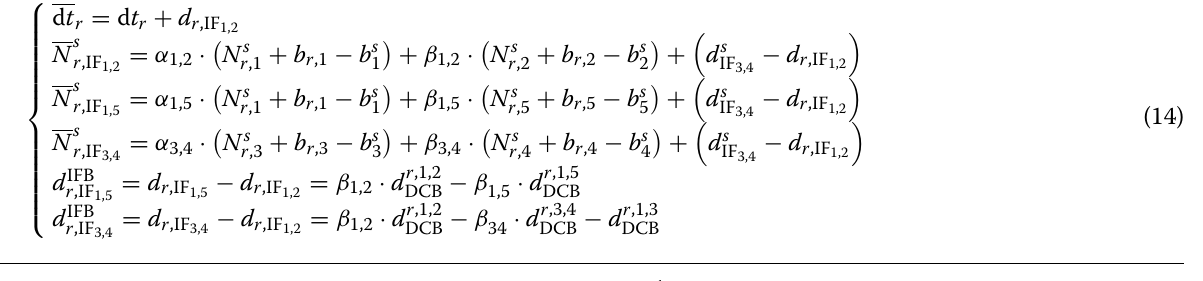
FF4: model with one single triple‑frequency and one dual‑frequency IF combined observables Different from FF2 and FF3 models, FF4 utilizes one sin- gle triple-frequency IF combination of B1C/B2a/B2 and one dual-frequency IF combination of B1I/B3I. The com-